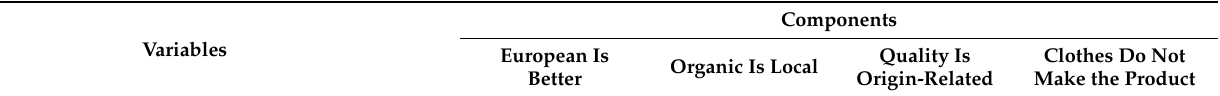
Table 3. Varimax rotated Principal Component Analysis. Each component was named in accordance with the consumption models described by the significance of